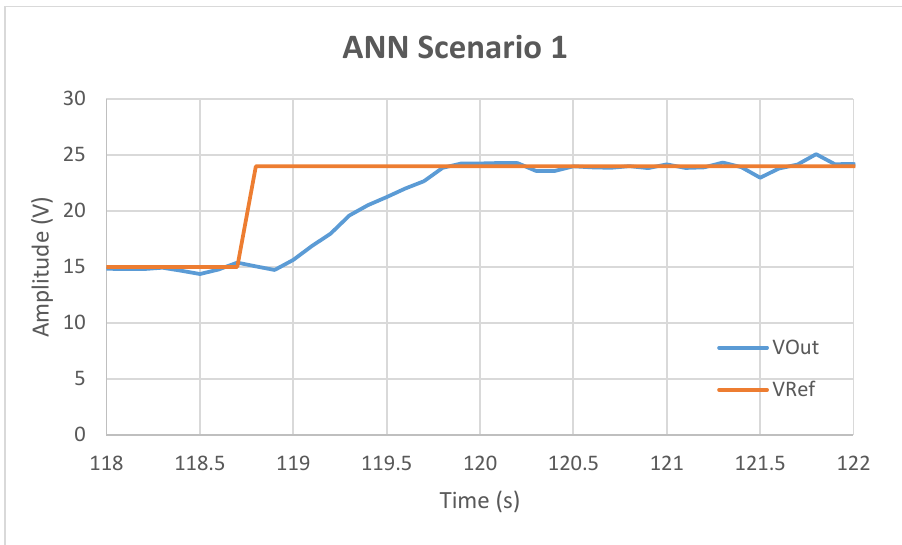
Figure 19. The response results of set point changes with artificial neural network.